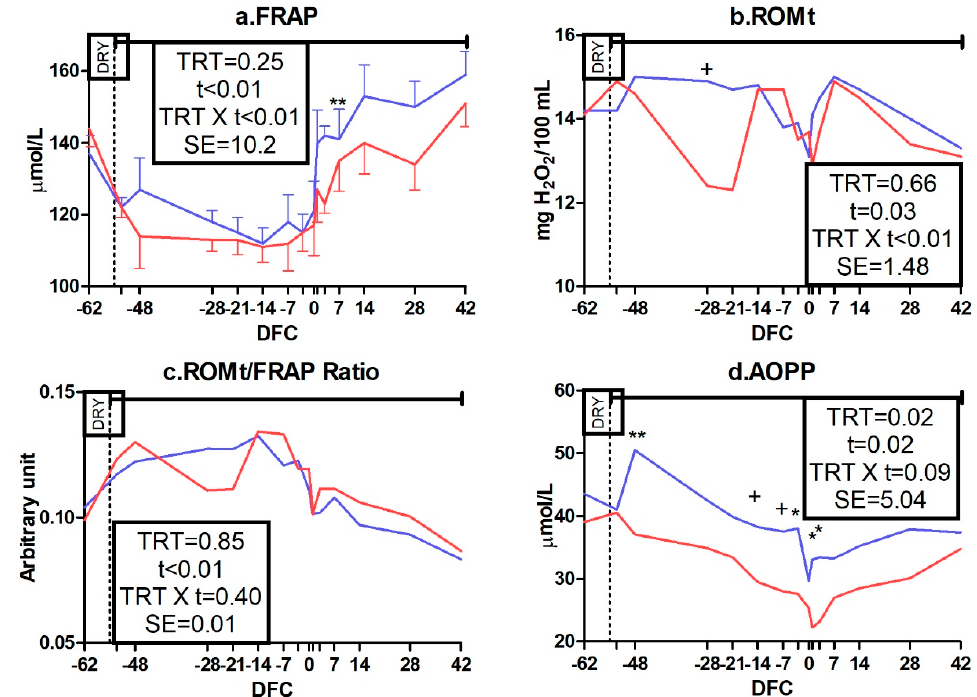
Figure 4. Time course of plasma concentrations of ferric-reducing antioxidant power (FRAP; ( a )), total reactive oxygen metabolites (ROMt; ( b )), reactive oxygen metabolites to ferric-reducing antioxidant power ratio (ROMt/FRAP ratio; ( c )) and advanced oxidation of proteins product (AOPP; ( d )) in control dairy cows (CTR; blue line, n = 5) and cows receiving 65 g*d − 1 of Omnigen-AF ® as top-dress (IMS; red line, n = 5) between − 55 and 42 days from calving. Upper solid line indicates timing of treatment administration. TRT is treatment effect; t is time effect; TRT × t is the treatment × time interaction effect (** is p < 0.01; * is p < 0.05; + is p < 0.10). DFC is days from calving; DRY is dry-off day ( − 55 days from expected calving); SE is standard error. Table 4. Blood cells profile in control dairy cows (n = 5) or cows receiving 65 g*d − 1 of Omnigen-AF ® as top-dress between − 55 and 42 days from calving (n = 5). Item,